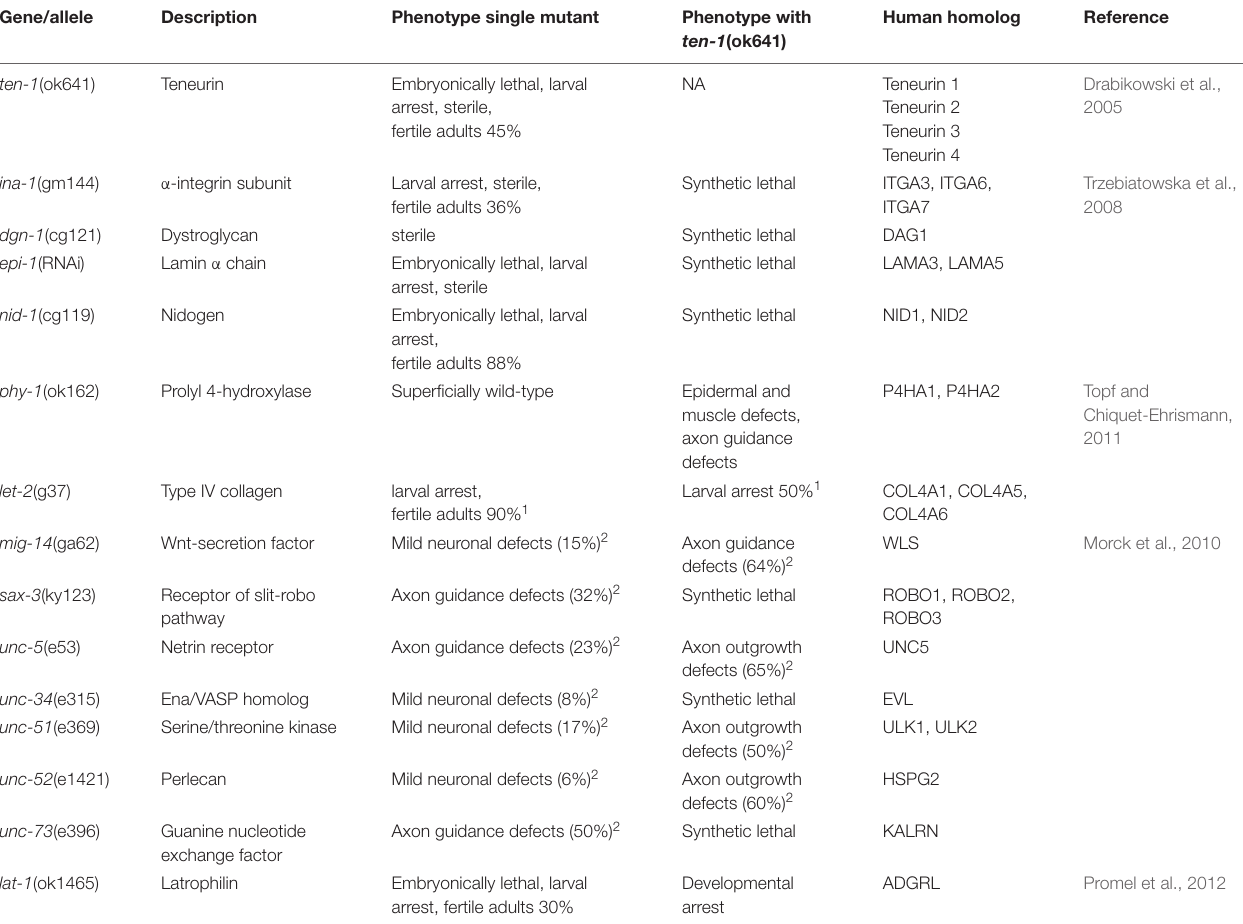
TABLE 1 | Genetic interactions with ten-1 that shape neuronal networks in C. elegans .